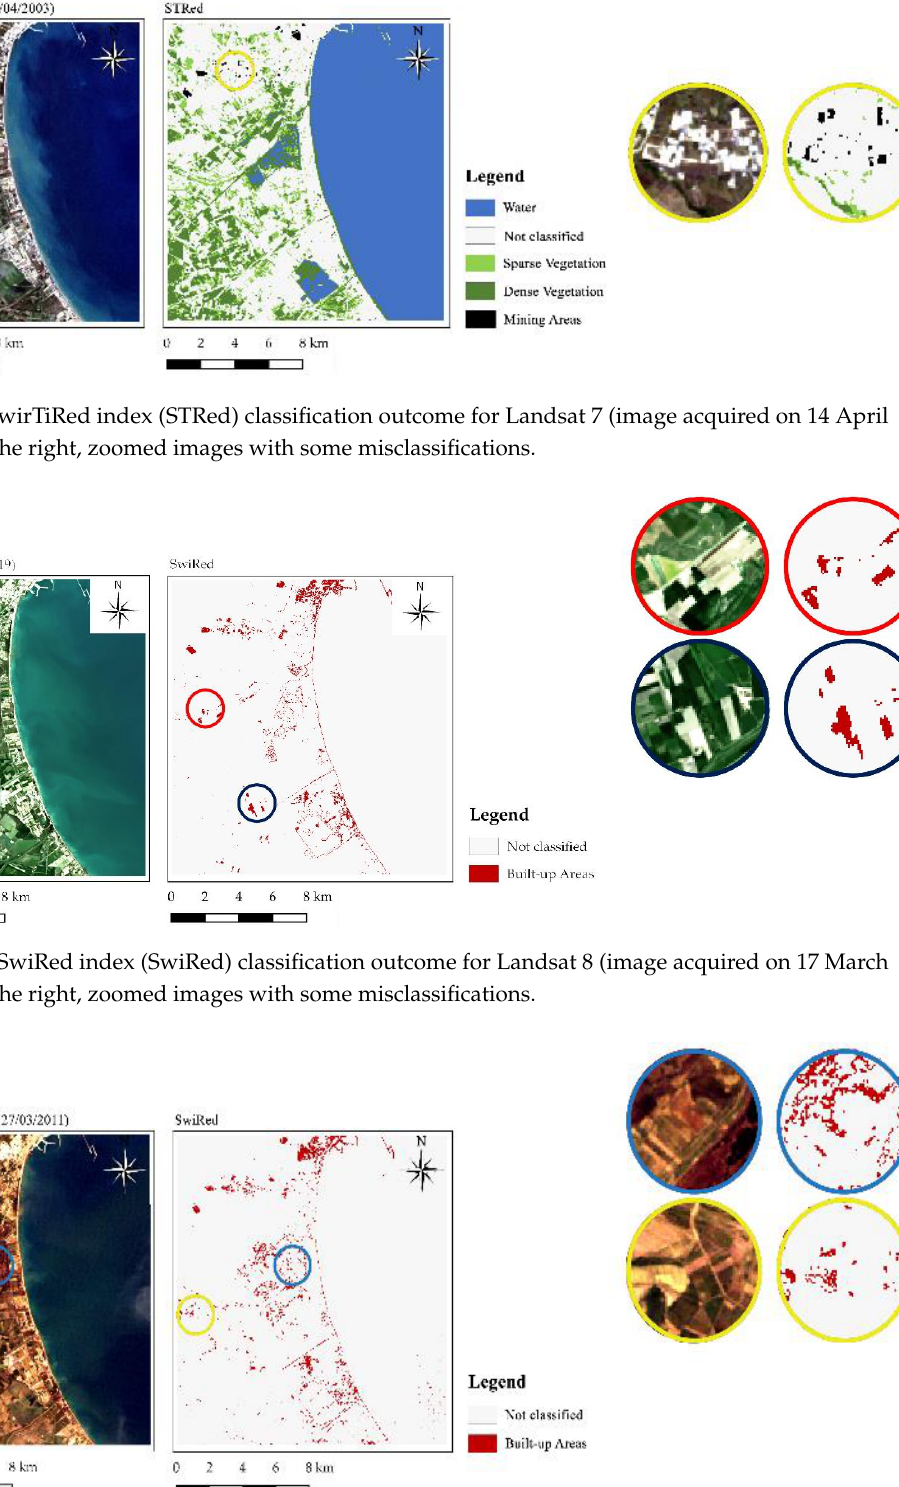
Figure 8. SwirTiRed index (STRed) classification outcome for Landsat 5 (image acquired on 5 October 2011). On the right, zoomed images with some misclassifications.